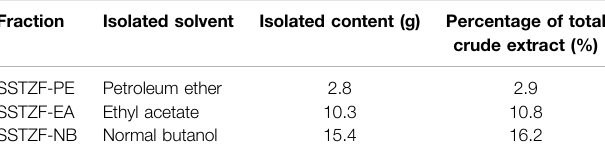
TABLE 2 | Fractions of SSTZF and